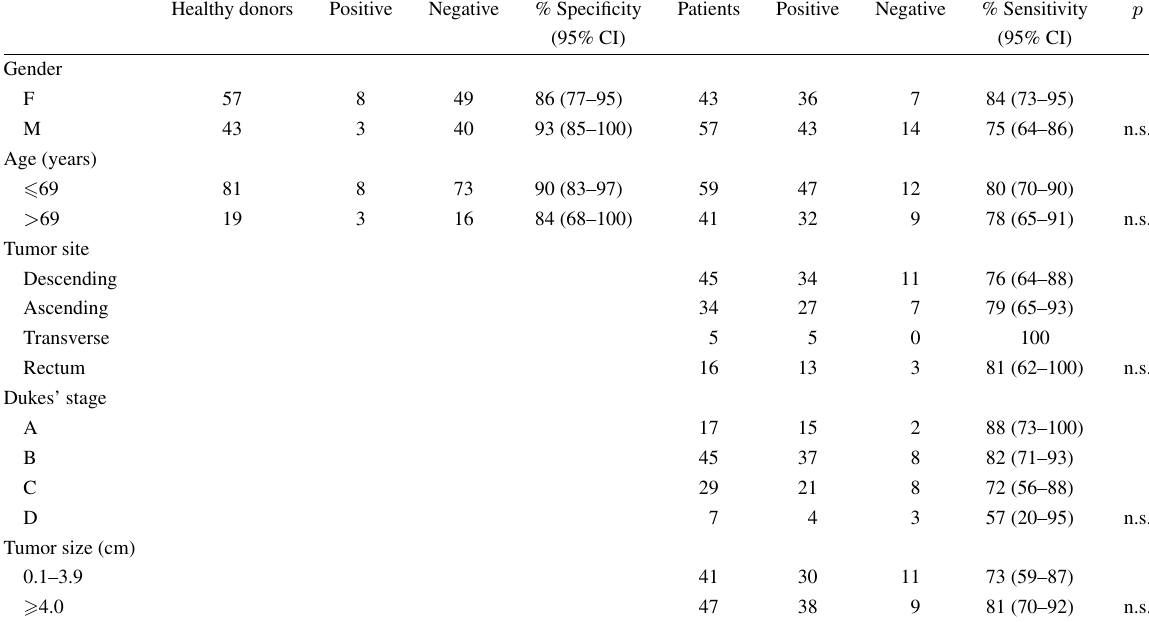
Sensitivity and specificity ∗ as a function clinical and pathological